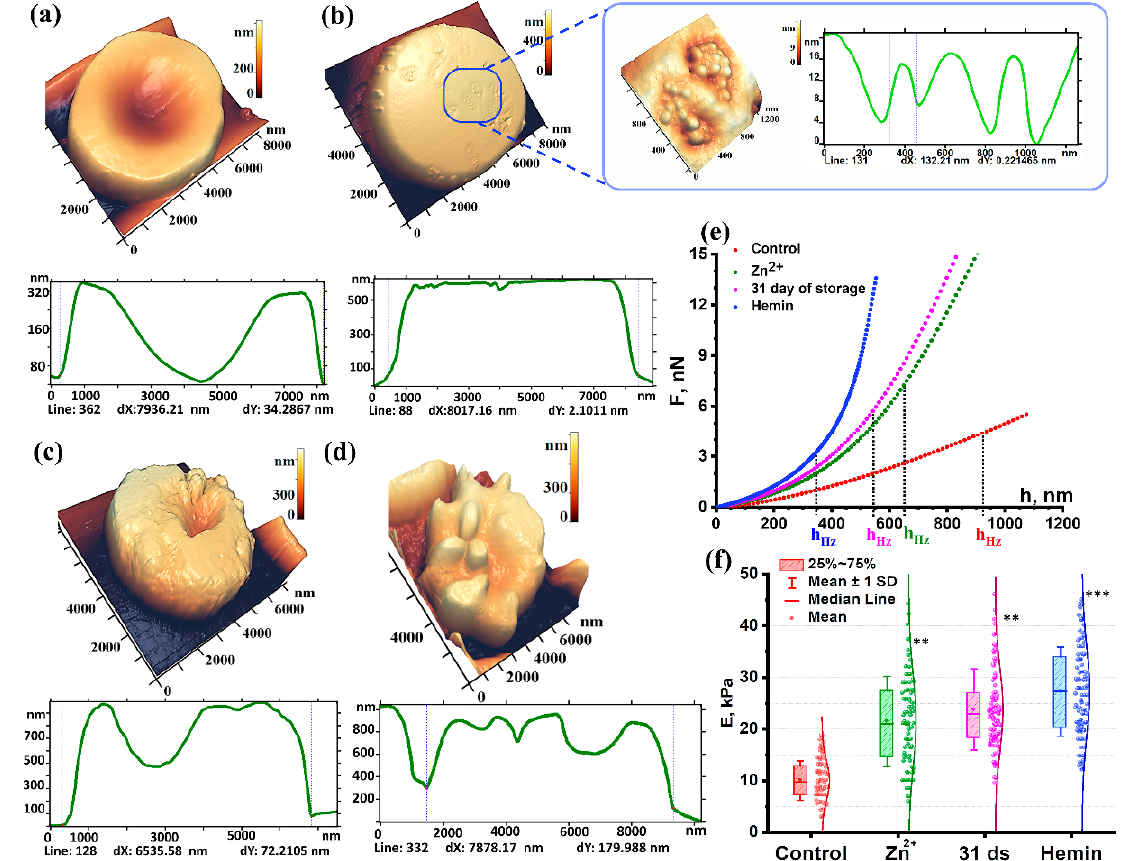
Figure 2. AFM image of the red blood cell (RBC) morphology (10 × 10 µm 2 ) in air and their profiles, respectively: ( a ) Control; ( b ) RBC after exposure to hemin, 3D AFM image of a 2000 × 2400 nm 2 area with granular structures after exposure to hemin and domain structure profile; ( c ) RBC after exposure to zinc ions; ( d ) RBC on day 31 of storage; ( e ) Force curves of RBCs in liquid on exposure to different agents, the curves are the average over all the curves for a specific condition; ( f ) Change in Young’s modulus depending on pathogenic factors. Data are presented as box plots. One-way ANOVA test followed by post hoc. Tukey was used: ** p < 0.01, *** p < 0.001 compared to control. Normally, the RBC diameter is 7900 ± 800 nm. The maximum height of the discocyte torus is 320 ± 80 nm (Figure 2a). The profile marker (dotted line on the cell surface) is drawn to show the RBC concavity and estimate its height. Packed RBCs stored for 2–6 days were taken as control. When the profile was evaluated using the spatial Fourier transform method, L 1 of the membrane nanosurface was 1133 ± 150 nm, L 2 was 90 ± 10, and the roughness height h 1 did not exceed 5.6 ± 1.5 nm, while h 2 was 1.1 ± 0.5 nm. The data are presented in Table 1. It shows the L 1 , h 1 , L 2 , h 2 values as mean ± standard deviation, the ratios of the mean and the control values are given in